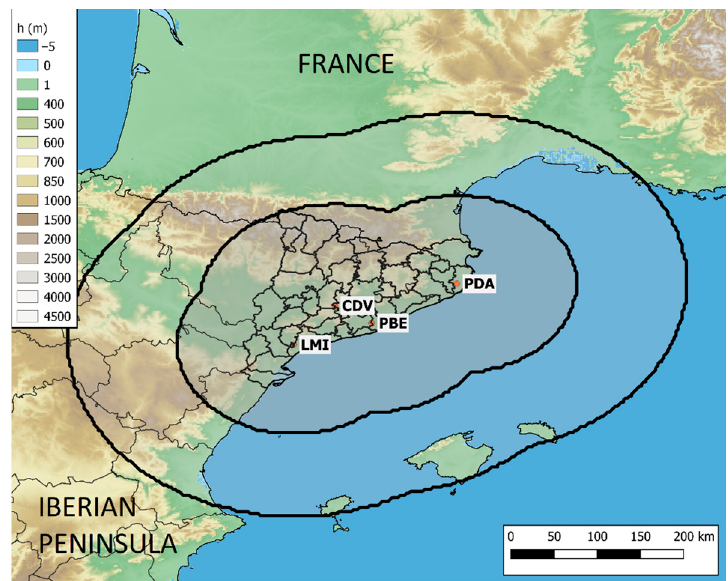
Figure 2. Map showing the north-eastern Iberian Peninsula and southern France. The black outer line represents the long-range coverage of XRAD, and the inner line represents the short-range coverage. The labels and orange dots correspond to each XRAD radar. LMI (La Miranda), CDV (Creu del vent), PBE (La Panadell), and PDA (Puig d’Arques i Cruïlles).